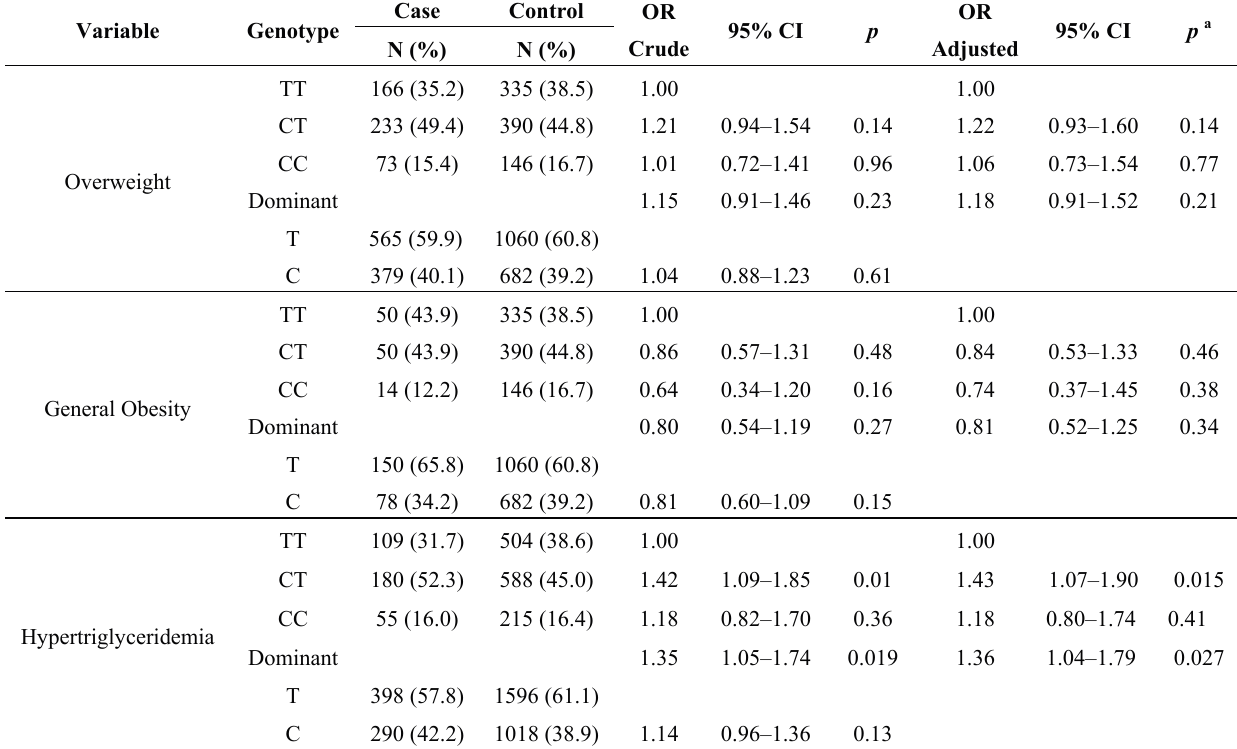
Table 4. Genotype frequencies of STAT3 polymorphism rs957970 and its association with the risks of metabolic